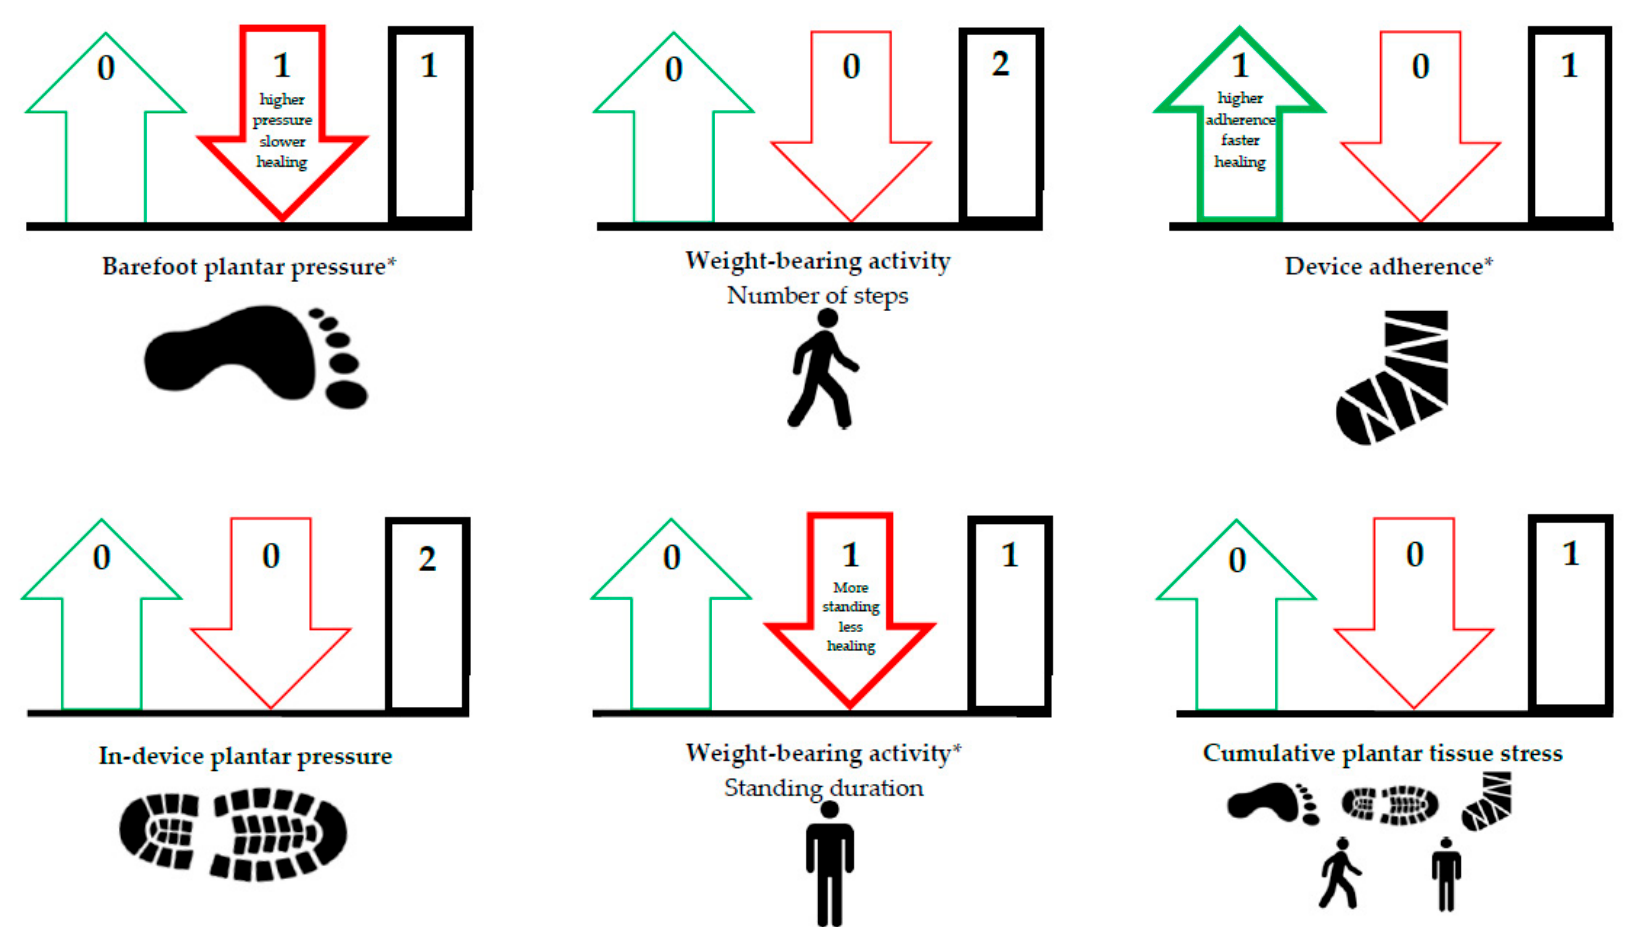
Figure 3. Overview of the results per foot-loading factor for ulcer healing. Arrow up ( green ) = favorable association; arrow down ( red ) = unfavorable association; rectangle ( black ) = no association. Thick outline of arrow or rectangle means that there is evidence, thin outline means that there is no evidence. The number at the top in the arrow or rectangle is the number of studies found for the association in that direction. * Some publications investigated multiple associations, therefore the numbers in the figure do not always correspond to the number of included publications.